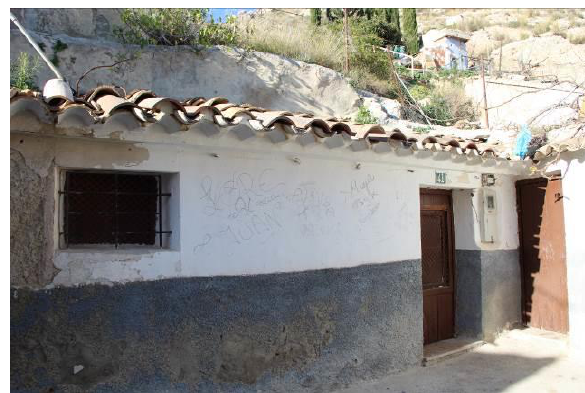
Figure 11. Exterior of the c asón on calle Mizas no. 41, exterior and detail of the interior (Source: authors).